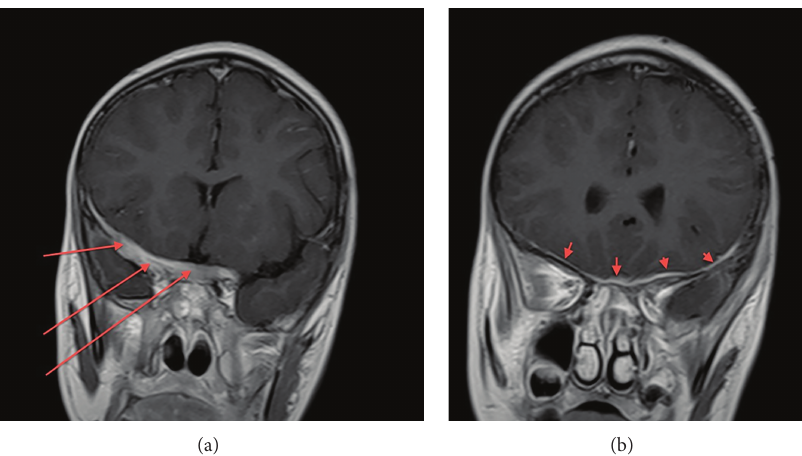
Figure 1: Coronal post-Gad T1WI FSE. There is diffuse pachymeningeal enhancement along the anterior skull base (red arrows).